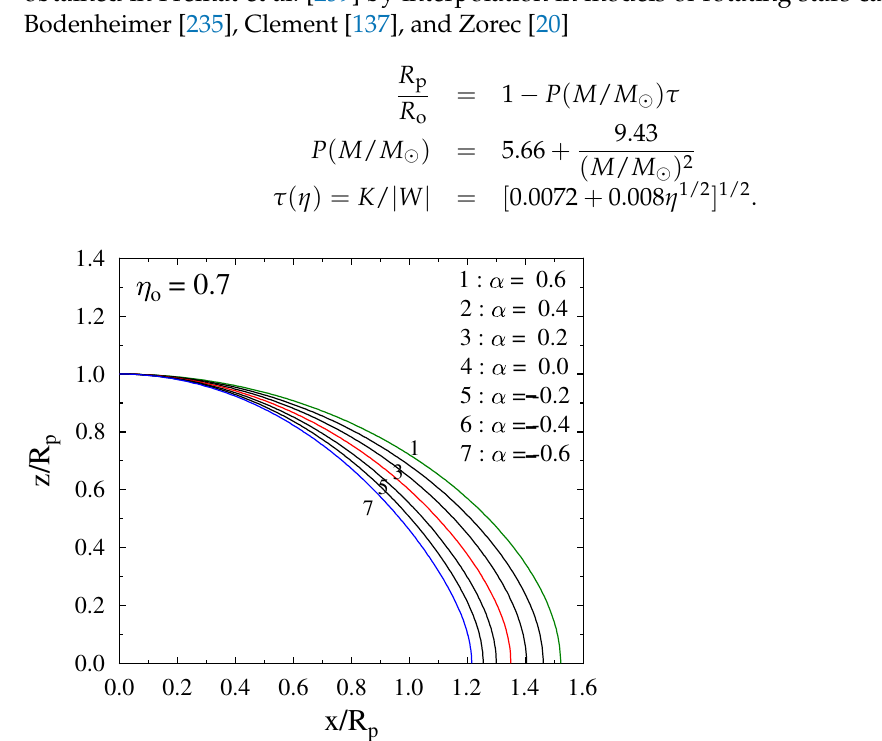
Figure 18. Geometrical shape of stars having the average surface rotational parameter η o = 0.7, and latitudinal differential rotations given by Equation (26) for several values of the parameter α . The rigid rotation ( α = 0) is indicated by the red